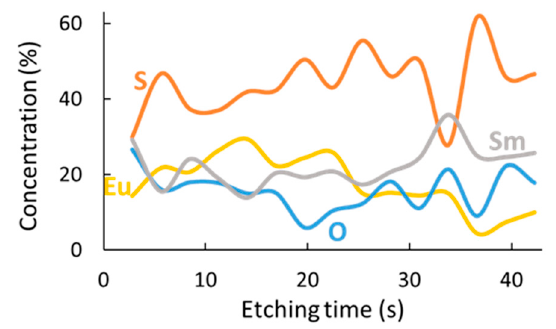
Figure 9. XPS depth profiling for the 6/12/6 nm SmS/EuS/SmS tri-layer system deposited at 400 °C.